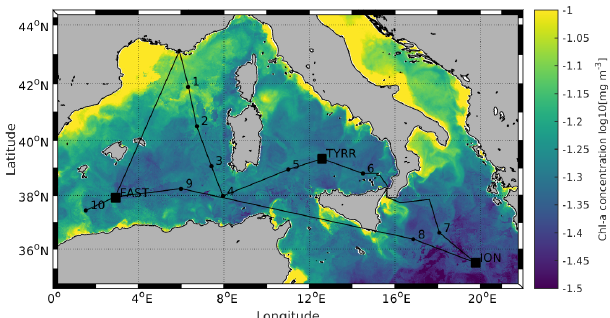
Figure 8. As Fig. 7, but for the satellite-derived surface chloro- phyll a concentration averaged over the entire duration of the cruise. (Courtesy of Louise Rousselet.)